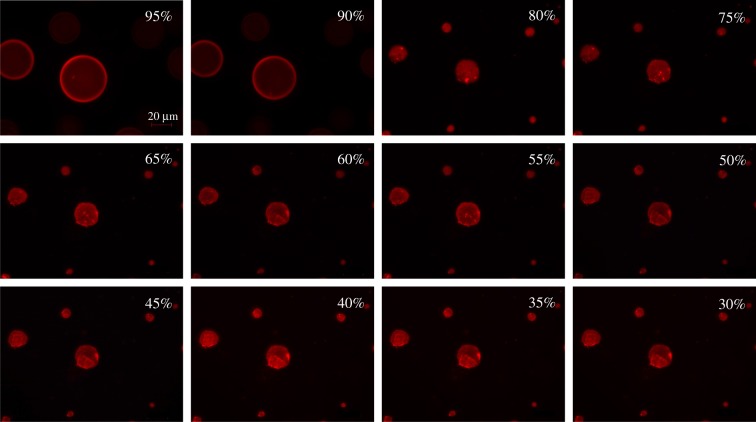
Fluorescence images of droplets exposed to decreasing RH. Droplets were aerosolized from a solution containing NaCl and mucin in water. The red colour indicates mucin. Droplets were initially exposed at 100% RH, and then the RH was ramped down at 5%/min. Droplets exposed at near-100% RH appeared similar to those at 95%. Scale bar represents 20 µm.